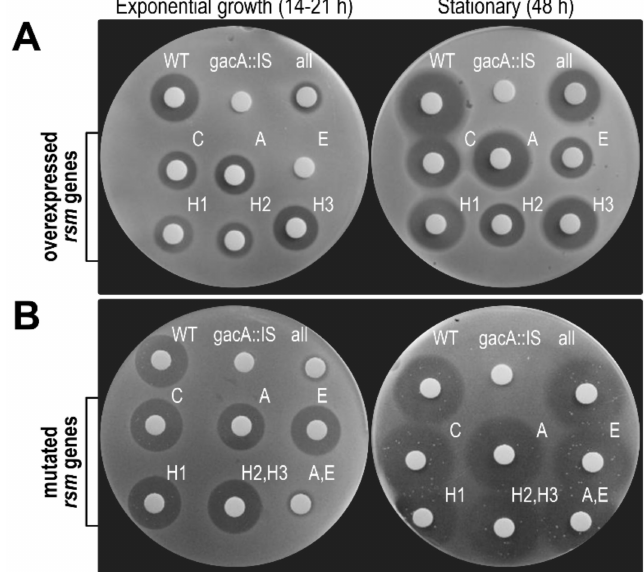
Figure 8. Di ff erential role of the Rsm homologues on phaseolotoxin biosynthesis. ( A ) Biosynthesis of phaseolotoxin by derivatives of P. amygdali pv. phaseolicola 1448A overexpressing di ff erent rsm genes or ( B ) containing mutations inactivating one, two or all (all, strain Mut-7-rsm) of the seven rsm homologues. WT, wild type strain 1448A; gacA::IS, a gacA -minus transposon mutant of strain 1448A. Strain labeled as H2,H3 (strain ∆ pA) is lacking alleles rsmH2 and the two copies of rsmH3 . Toxin production was evidenced as haloes of growth inhibition in an E. coli indicator assay. Pictures are representative of three independent